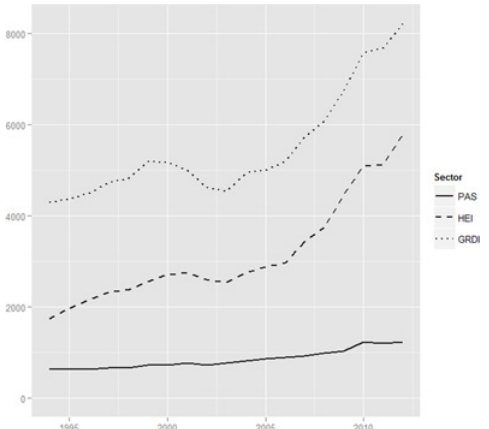
Fig 3. Gross domestic expenditures on R&D in million PLN according to PPSS sector, inflation adjusted data, base year 2010 (CPI taken from OECD statistics); data displays cumulative three-year moving